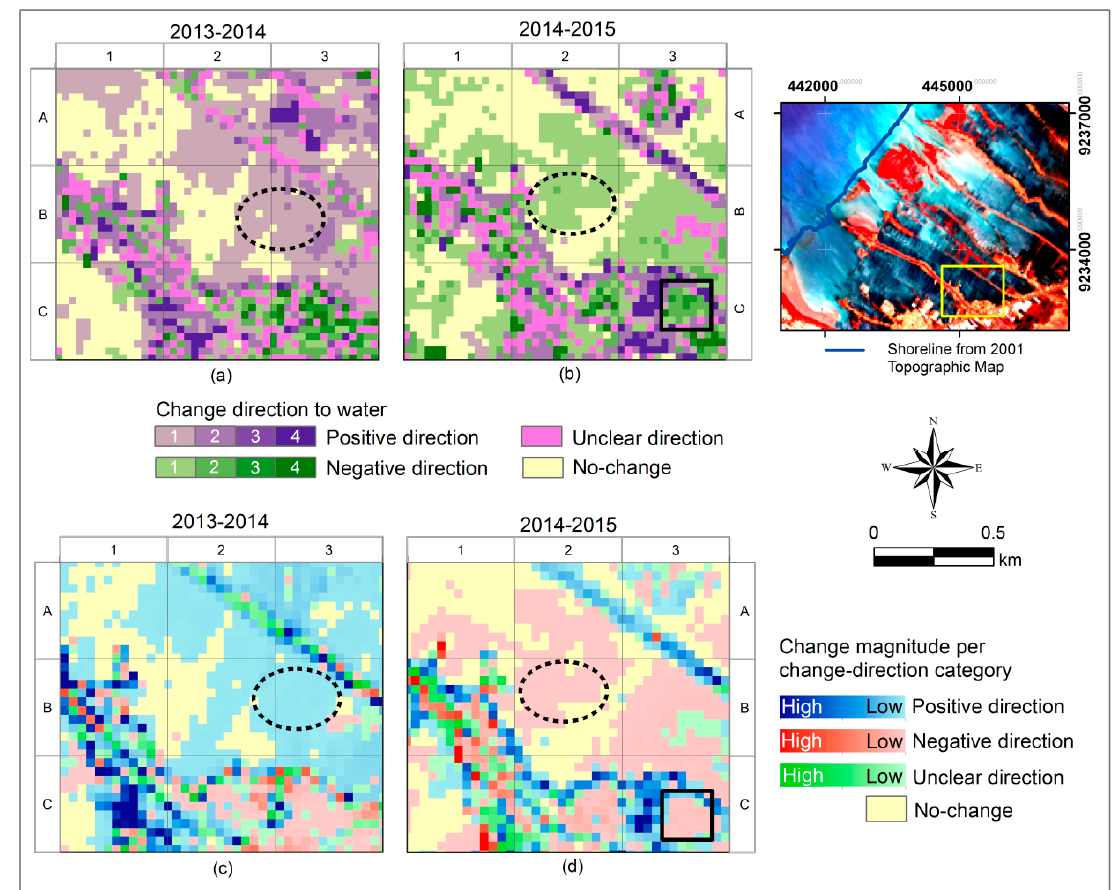
Figure 17. Water membership changes show a low change direction to positive direction in the period 2013-2014 ( a ); and to negative direction in the period 2014-2015 ( b ). The change magnitude values were low in both periods ( c,d ). This type of change was also observed as small patches of the coastal land (see black rectangle sites in ( b , d )).